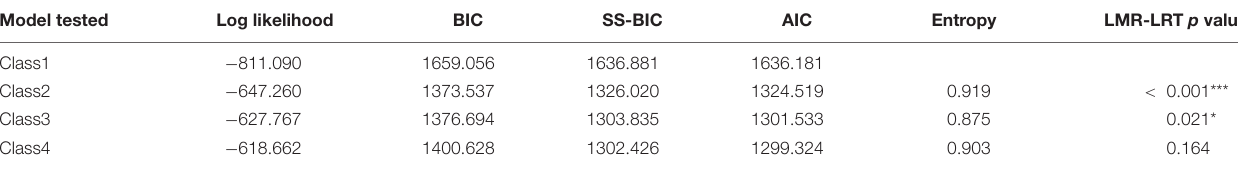
TABLE 2 | Goodness-of-fit statistics for 1–4 class